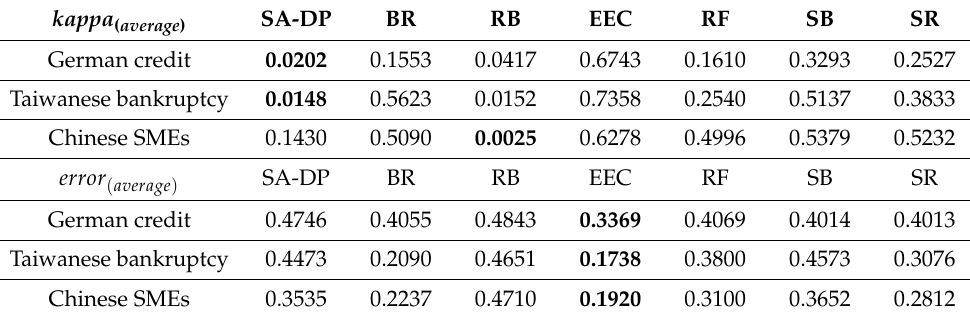
Table 10. Main information of each kappa-error